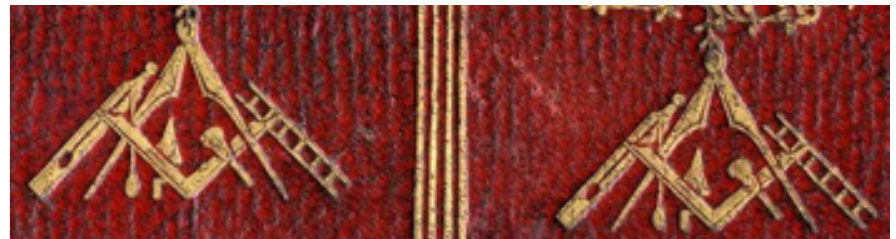
Fig. 12a. Laurence Dermott, Ahiman Rezon (London, 1787). Copyright and reproduced by permission of the Museum of Freemasonry, London.